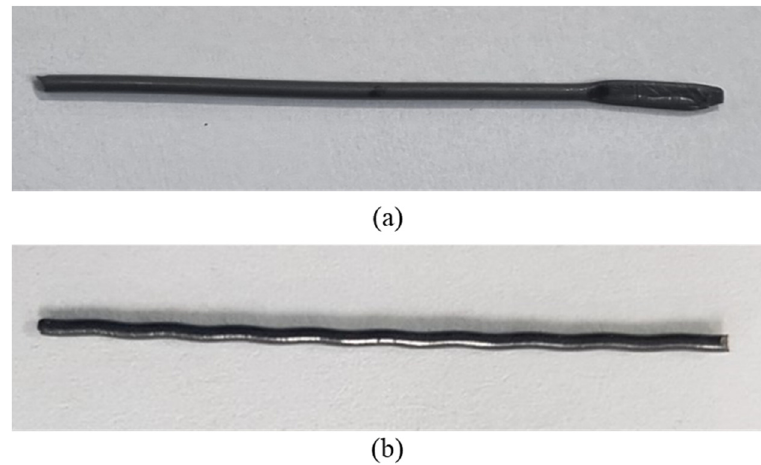
Figure 2: Photo of ( a ) paddled and ( b ) crimped fi